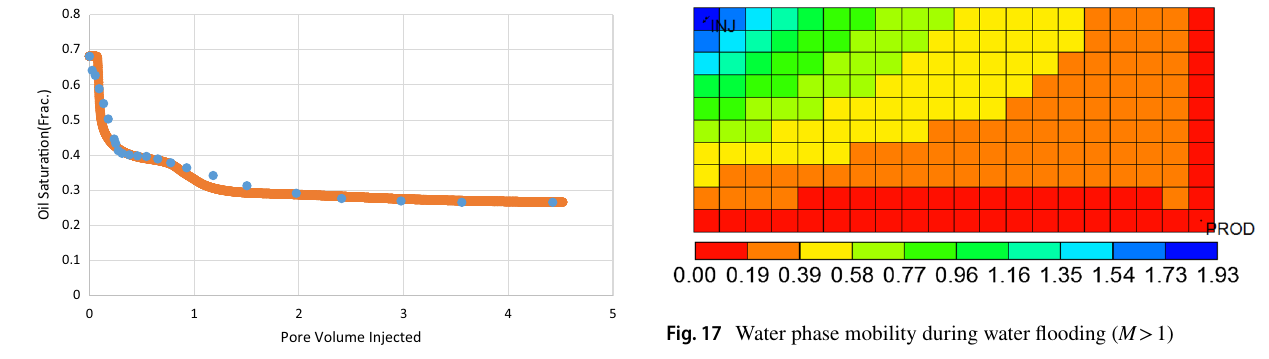
Fig. 17 Water phase mobility during water flooding ( M > 1)